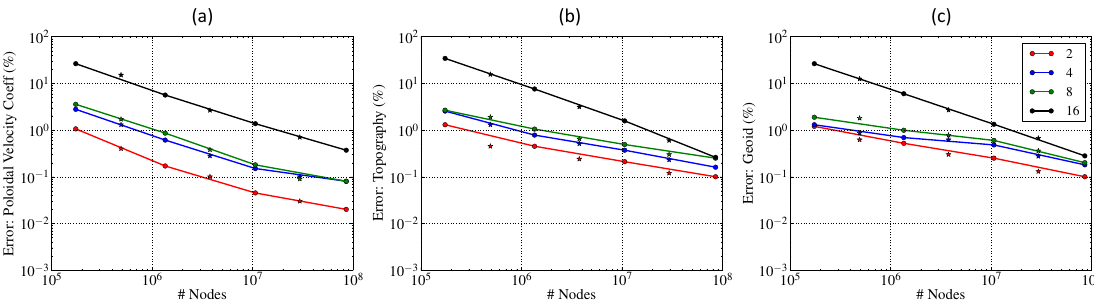
Fig. 4. Relative errors in numerical predictions with respect to semi-analytical solutions (e.g. Hager and O’Connell, 1981; Richards and Hager, 1984) for: (a) normalized harmonic coefficients for poloidal velocity at the surface and CMB (combined); (b) surface and CMB topography (combined); and (c) total geoid; for a range of uniform (circles) and non-uniform (stars) grids, at spherical harmonic degrees 2, 4, 8, and 16. Note that continuous lines connect the results from uniform cases.